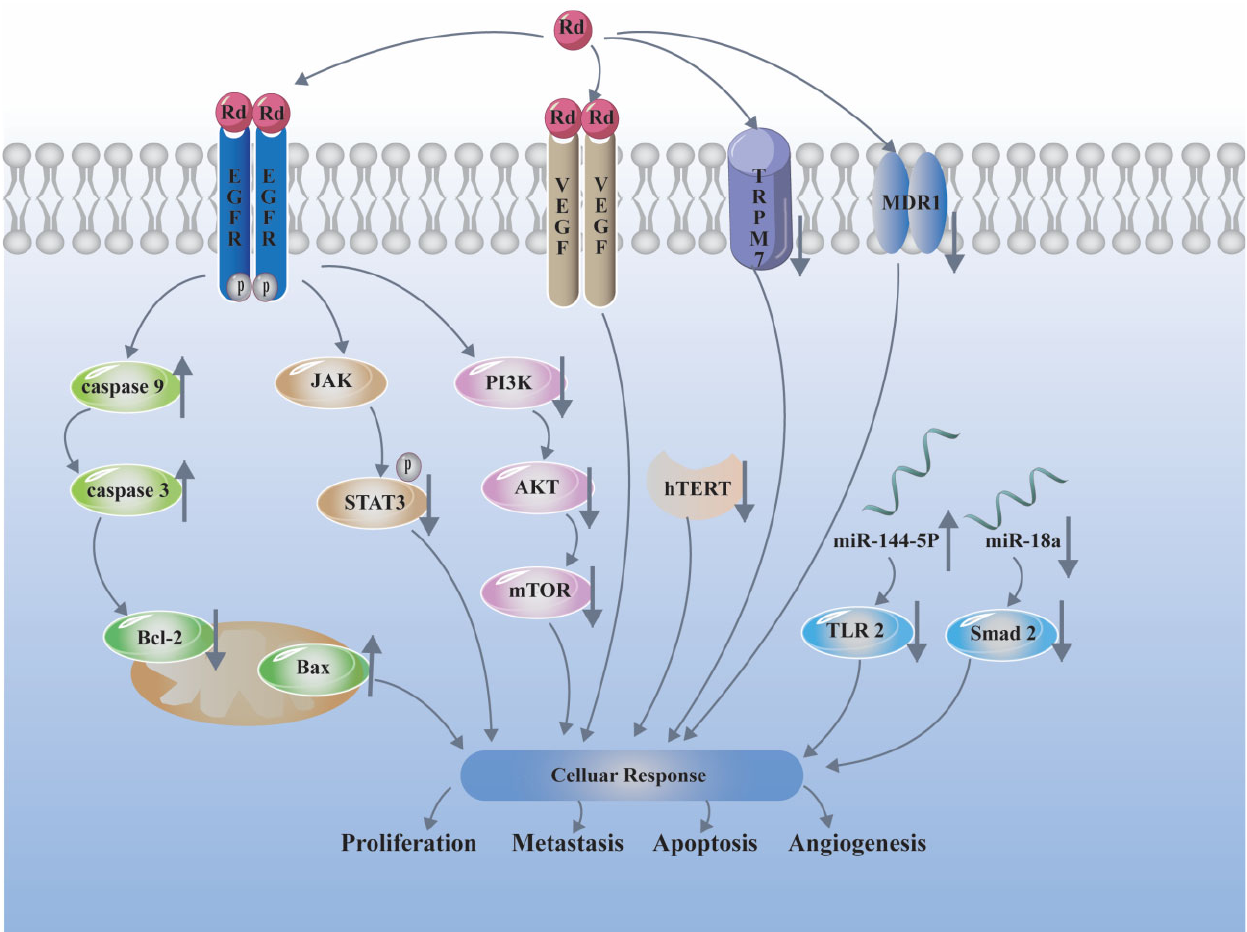
Figure 2. Anti ‐ cancer mechanism of ginsenoside Rd. “ ↓ ” means downregulation, “ ↑ ” means Figure 2. Anti-cancer mechanism of ginsenoside Rd. “ ↓ ” means downregulation, “ ↑ ” means upregu- upregulation.